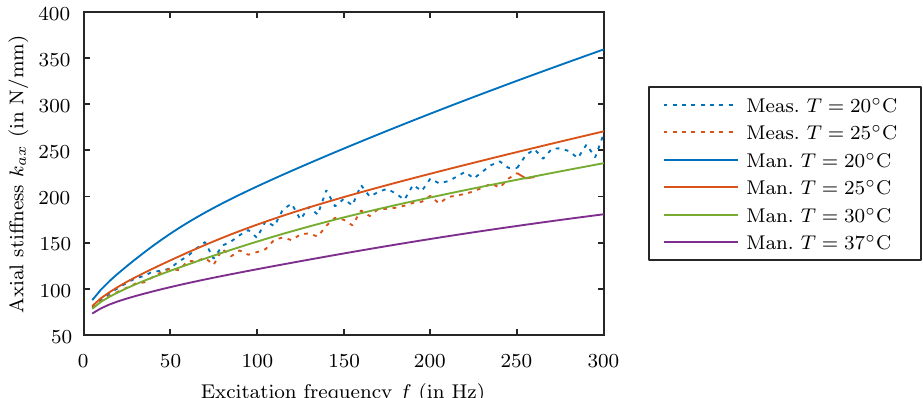
Figure 13. Comparison of measured probe stiffness with the manufacturer data.